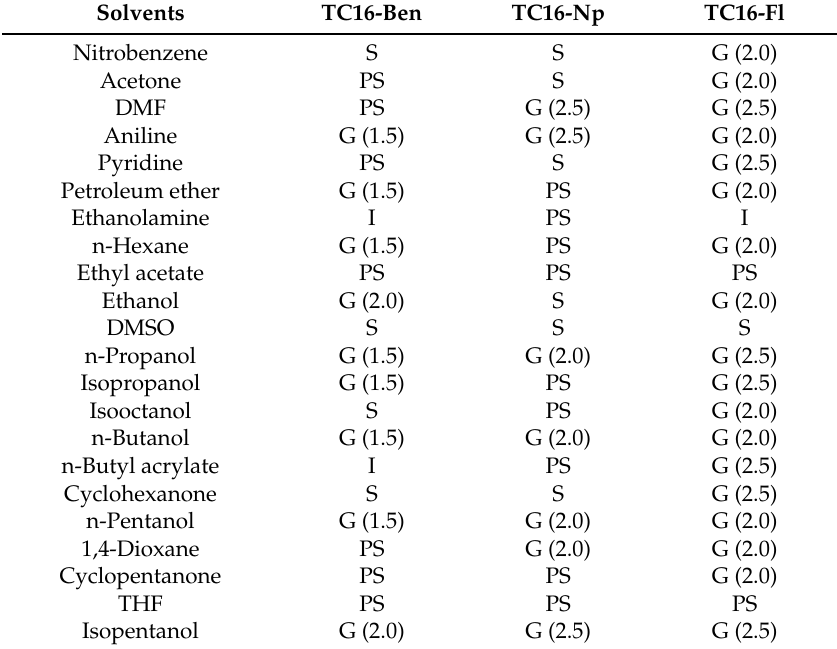
Table 1. Gelation behaviors of three amide derivatives at room temperature.